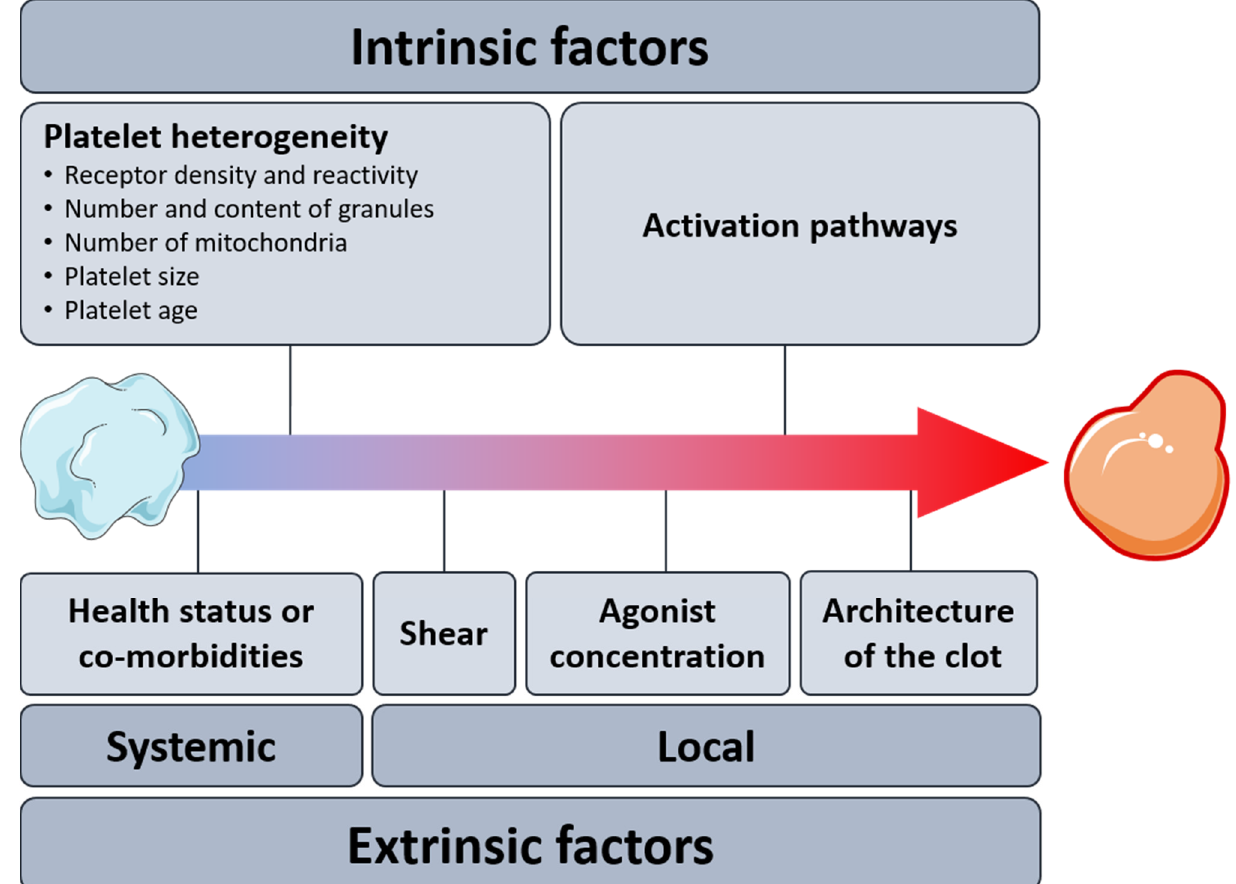
Figure 5. Intrinsic and extrinsic factors potentially driving the procoagulant response of